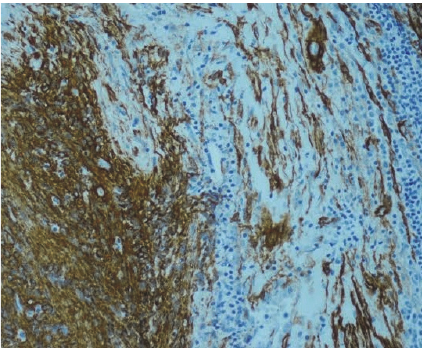
Figure 5: The spindle cells were diffusely immunoreactive for